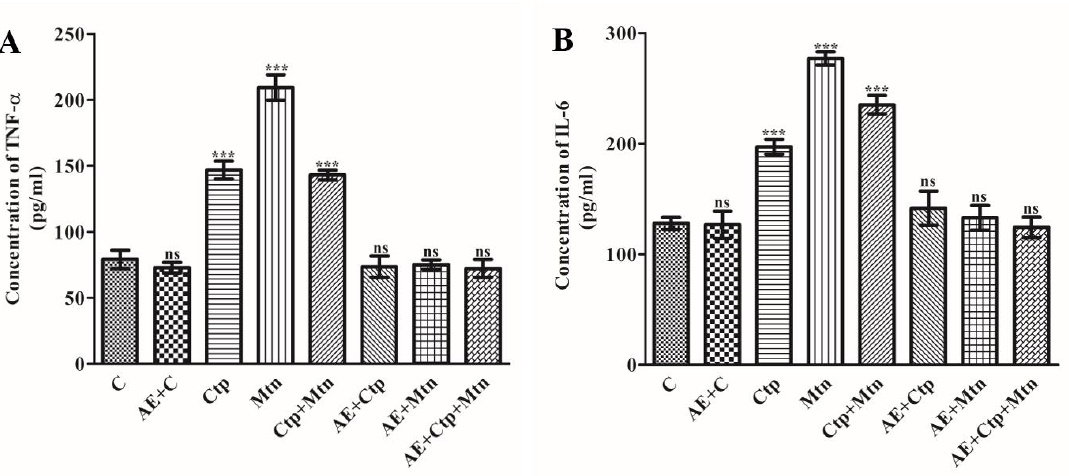
Figure 1. Effects of cartap, malathion and the aqueous extract of A. vera leaves on the levels of pro-inflammatory markers i.e., ( A ) TNF- α and ( B ) IL-6, in the rat blood serum. The procedures for the administration of pesticides, aqueous extract of A. vera leaves and the assay for TNF-α and IL-6 were mentioned in Materials and methods. The unit of the concentration of TNF-α and IL-6 were expressed as pg mL −1 . The data represent mean ± SD of 3 independent experiments. The values were significant at p < 0.05 as compared to control group.